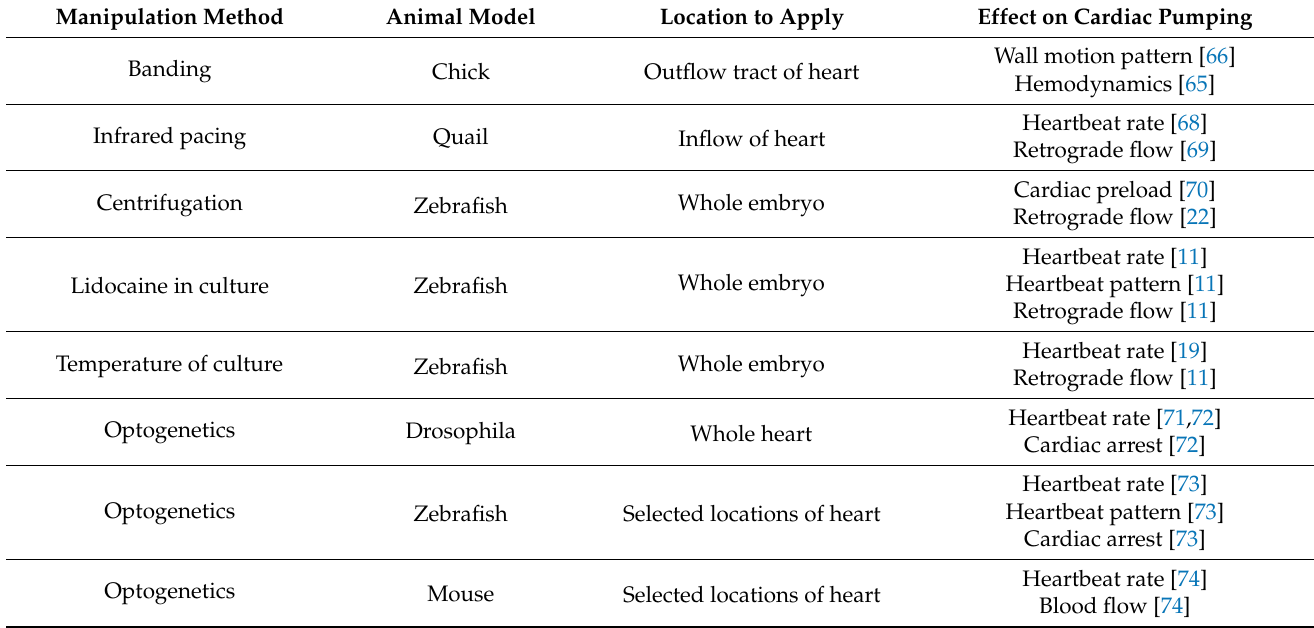
Table 1. Methods for manipulating the valveless pumping function in the embryonic